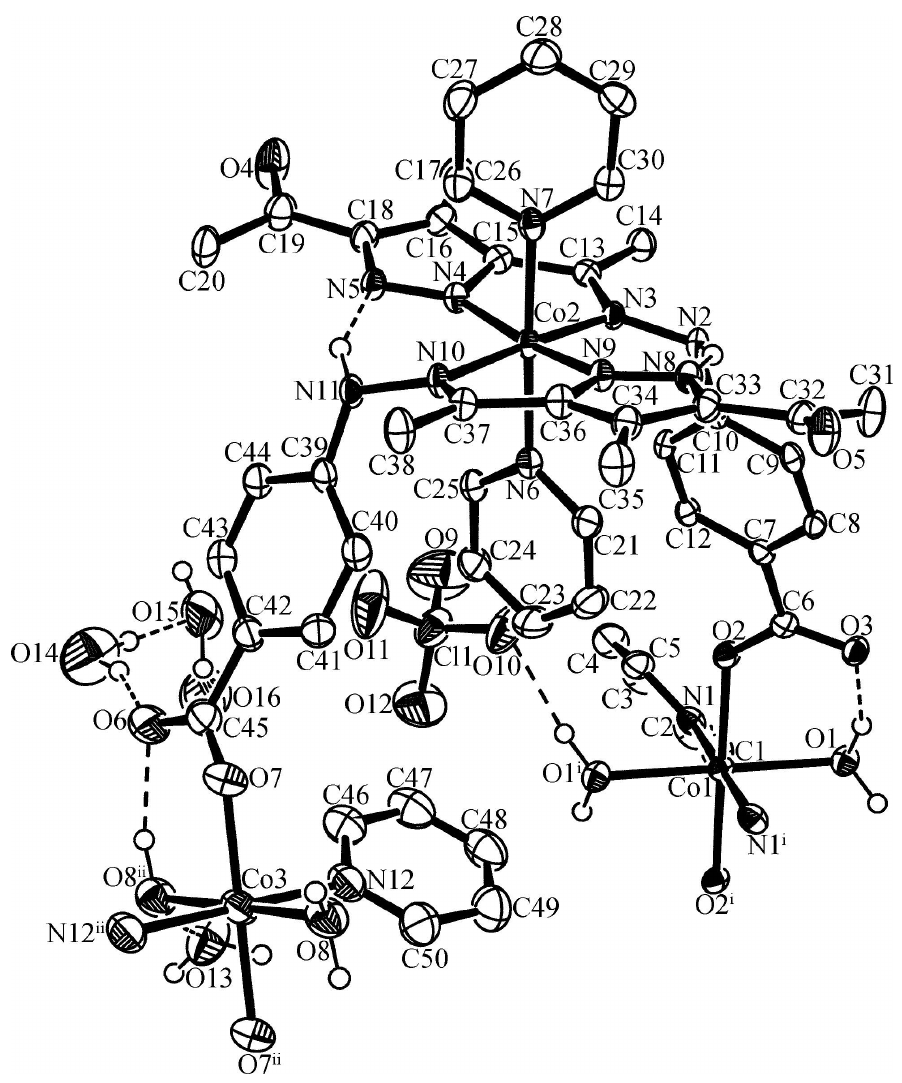
Figure 1 Monomeric fragment in the crystal structure of (I) with displacement ellipsoids drawn at the 50% probability level. Disordered positions of the water molecules (O15 and O16) and H-atoms not participating in hydrogen bonds are omitted for clarity. Symmetry code: i=1 - x , 1 - y , - z ; ii=1 - x , 1 - y , -1 - z